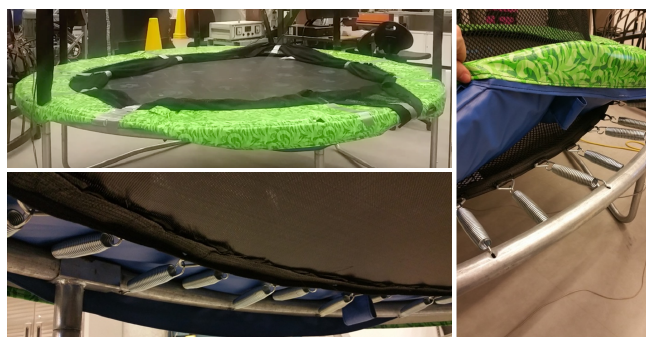
Figure 1. Details of the trampoline used in this research. Table 1. Trampoline dimensions and